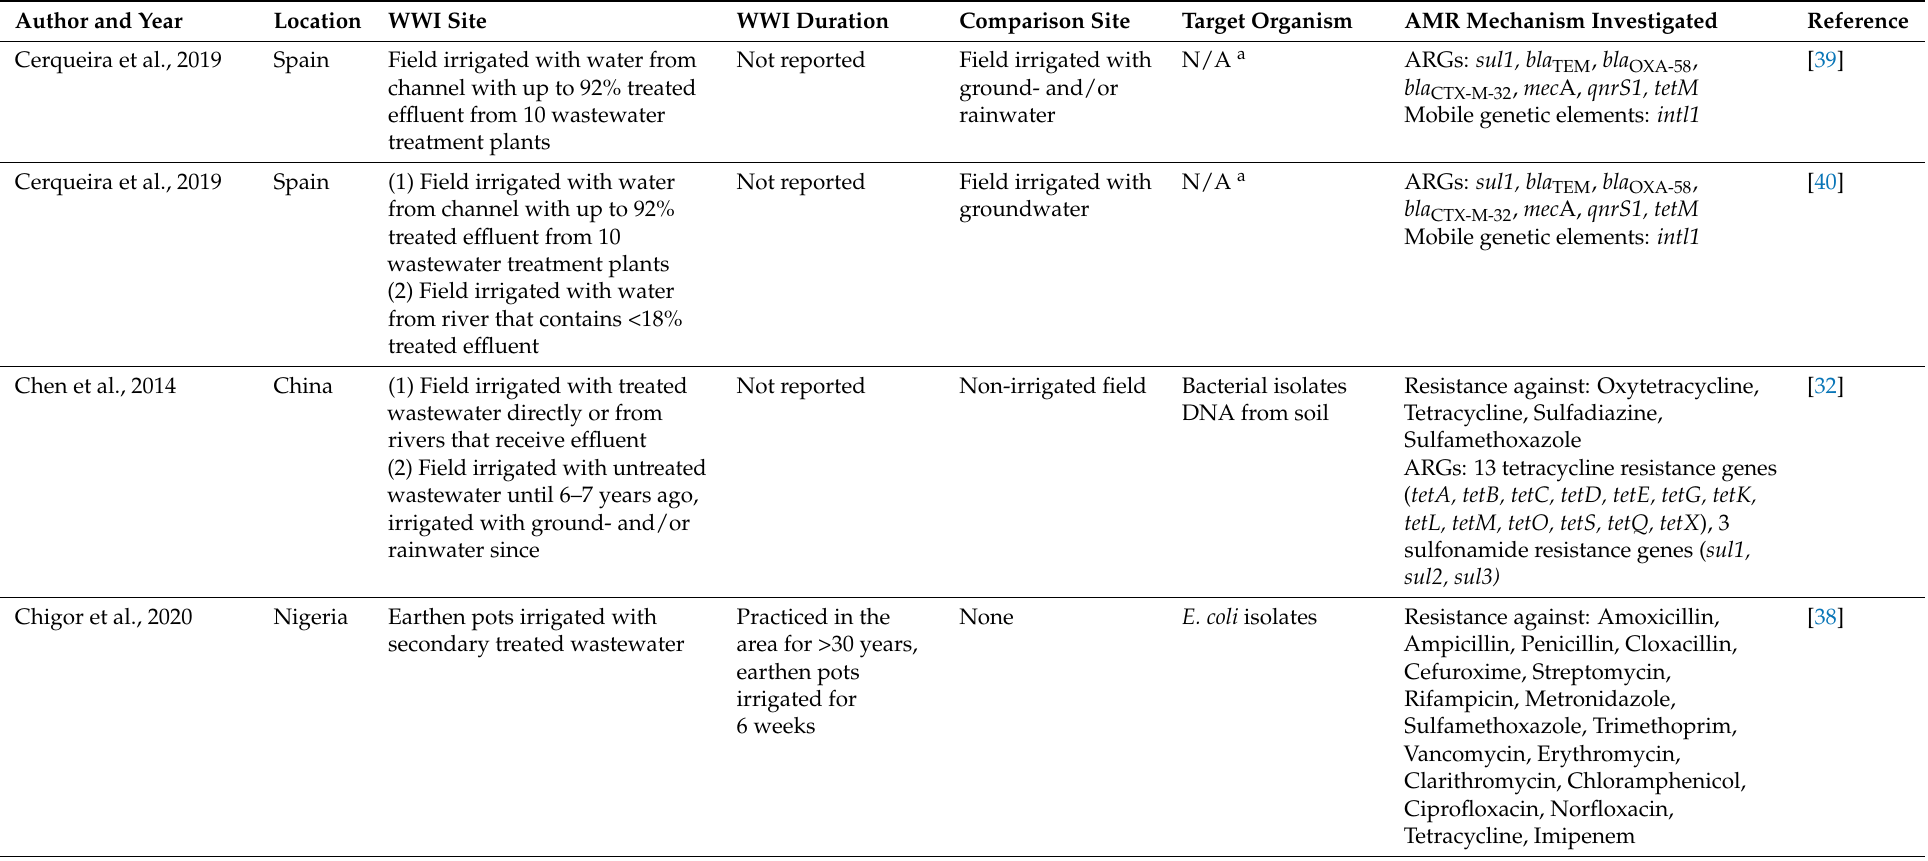
Table 2. Characteristics of studies on irrigation with treated